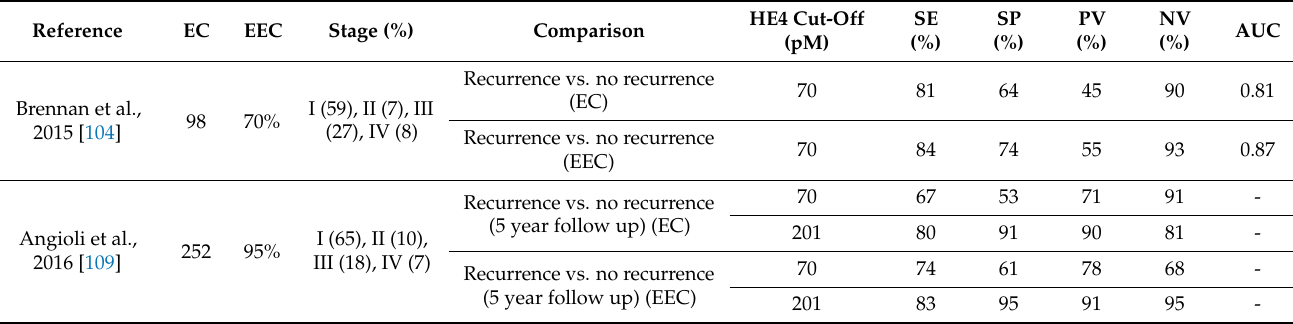
Table 4. Serum HE4 cut-off values and performance for EC